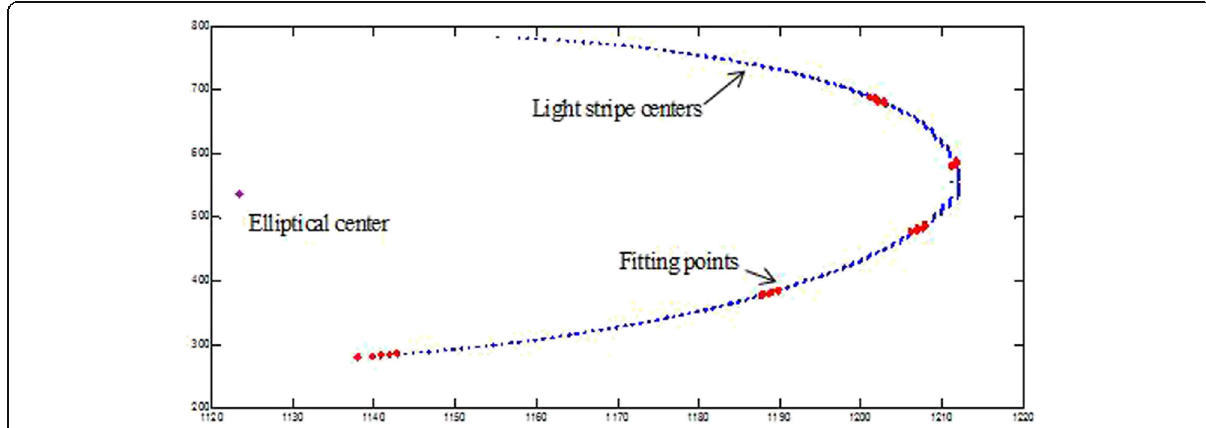
Fig. 12 The schematic diagram of light stipe (curve) center detection